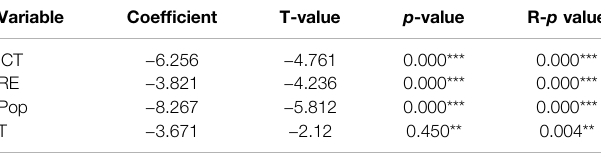
TABLE 4 | Co-integration technique (Westerland, 2007).